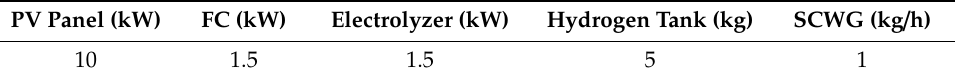
Table 5. Optimal configuration of the proposed HRES in scenario 2.